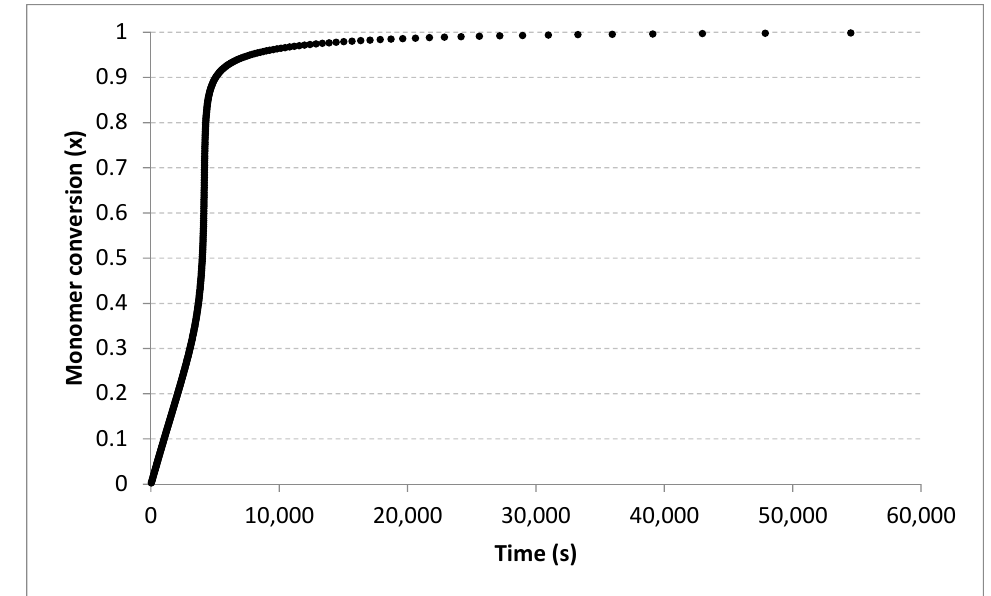
Figure 1. Adaptively sampled points (337) for the monomer conversion ( x ).